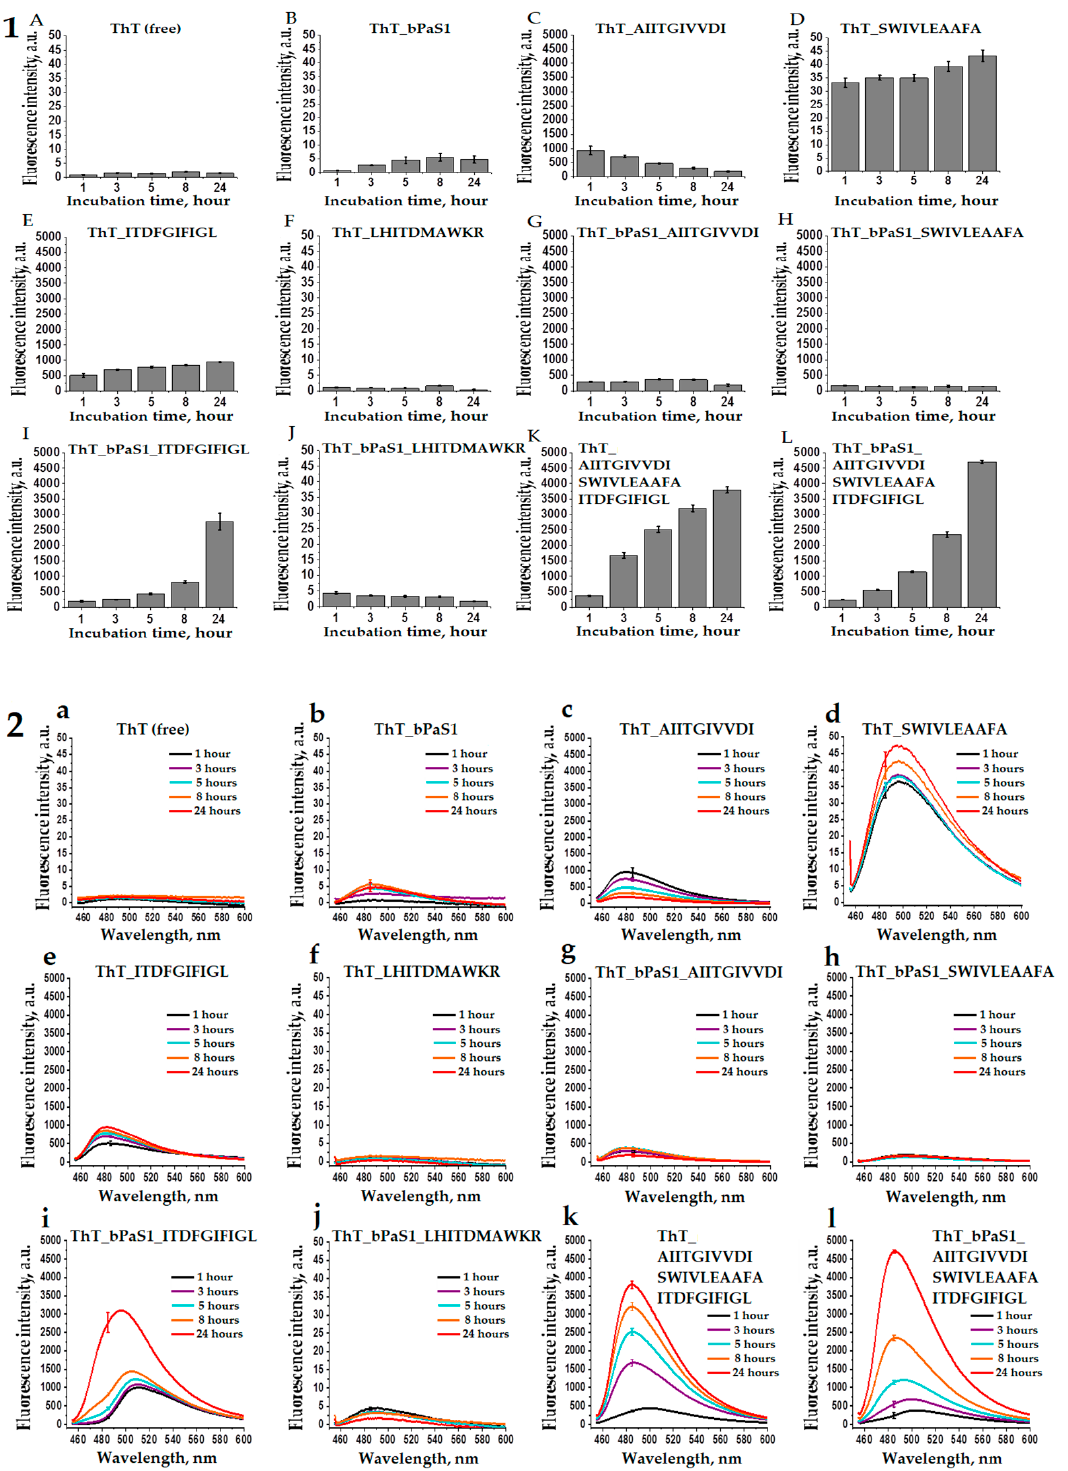
Figure 4. Histograms ( 1 ) and spectra ( 2 ) of fluorescence intensity of free thioflavin T ( A , a ) and in solution with bPaS1 ( B , b ), individual peptides AIITGIVVDI ( C , c ), SWIVLEAAFA ( D , d ), ITDFGIFIGL ( E , e ), LHITDMAWKR ( F , f ), a mixture of peptides ( K , k ), as well as in mixtures of bPaS1 with peptides ( G , g ), ( H , h ), ( I , i ), ( J , j ), ( L , l ). Error bars with standard deviations for the mean values of the measured fluorescence intensity after 1, 3, 5, 8, and 24 h of incubation are